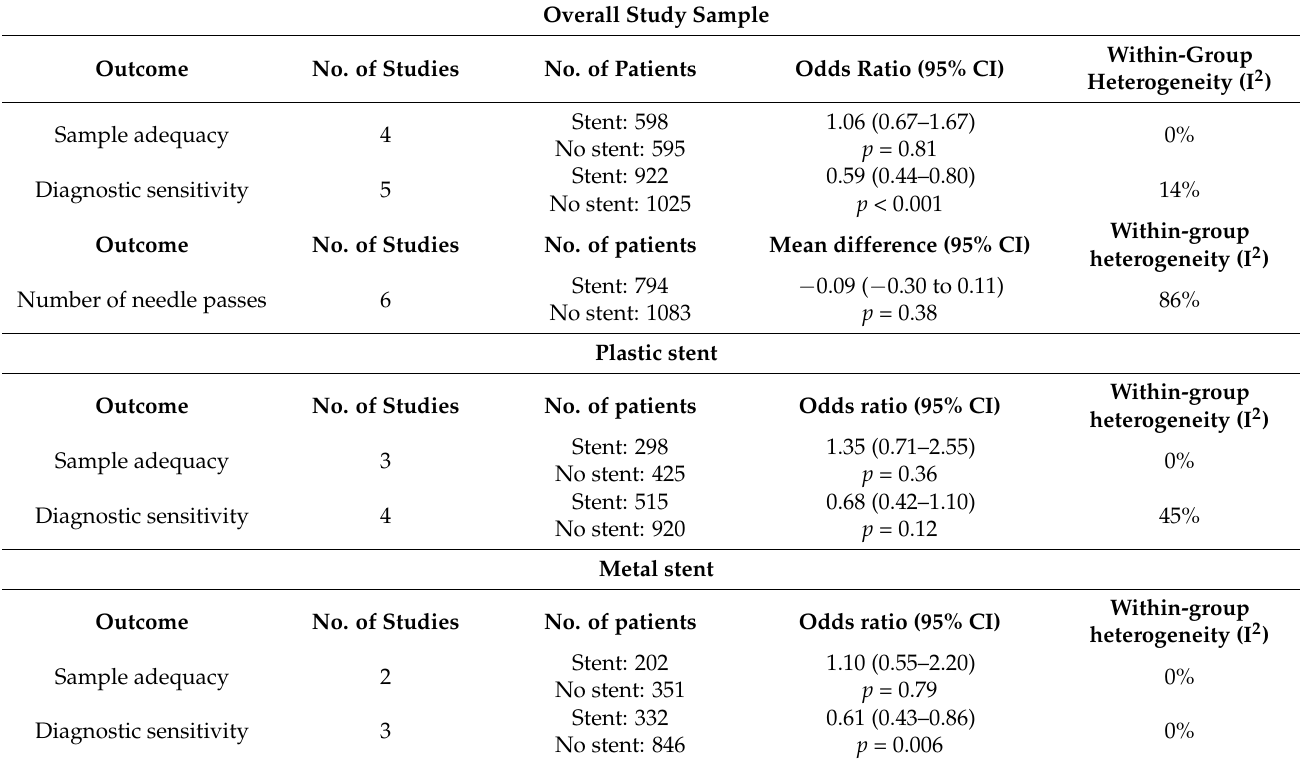
Table 3. Secondary outcomes. Overall Study